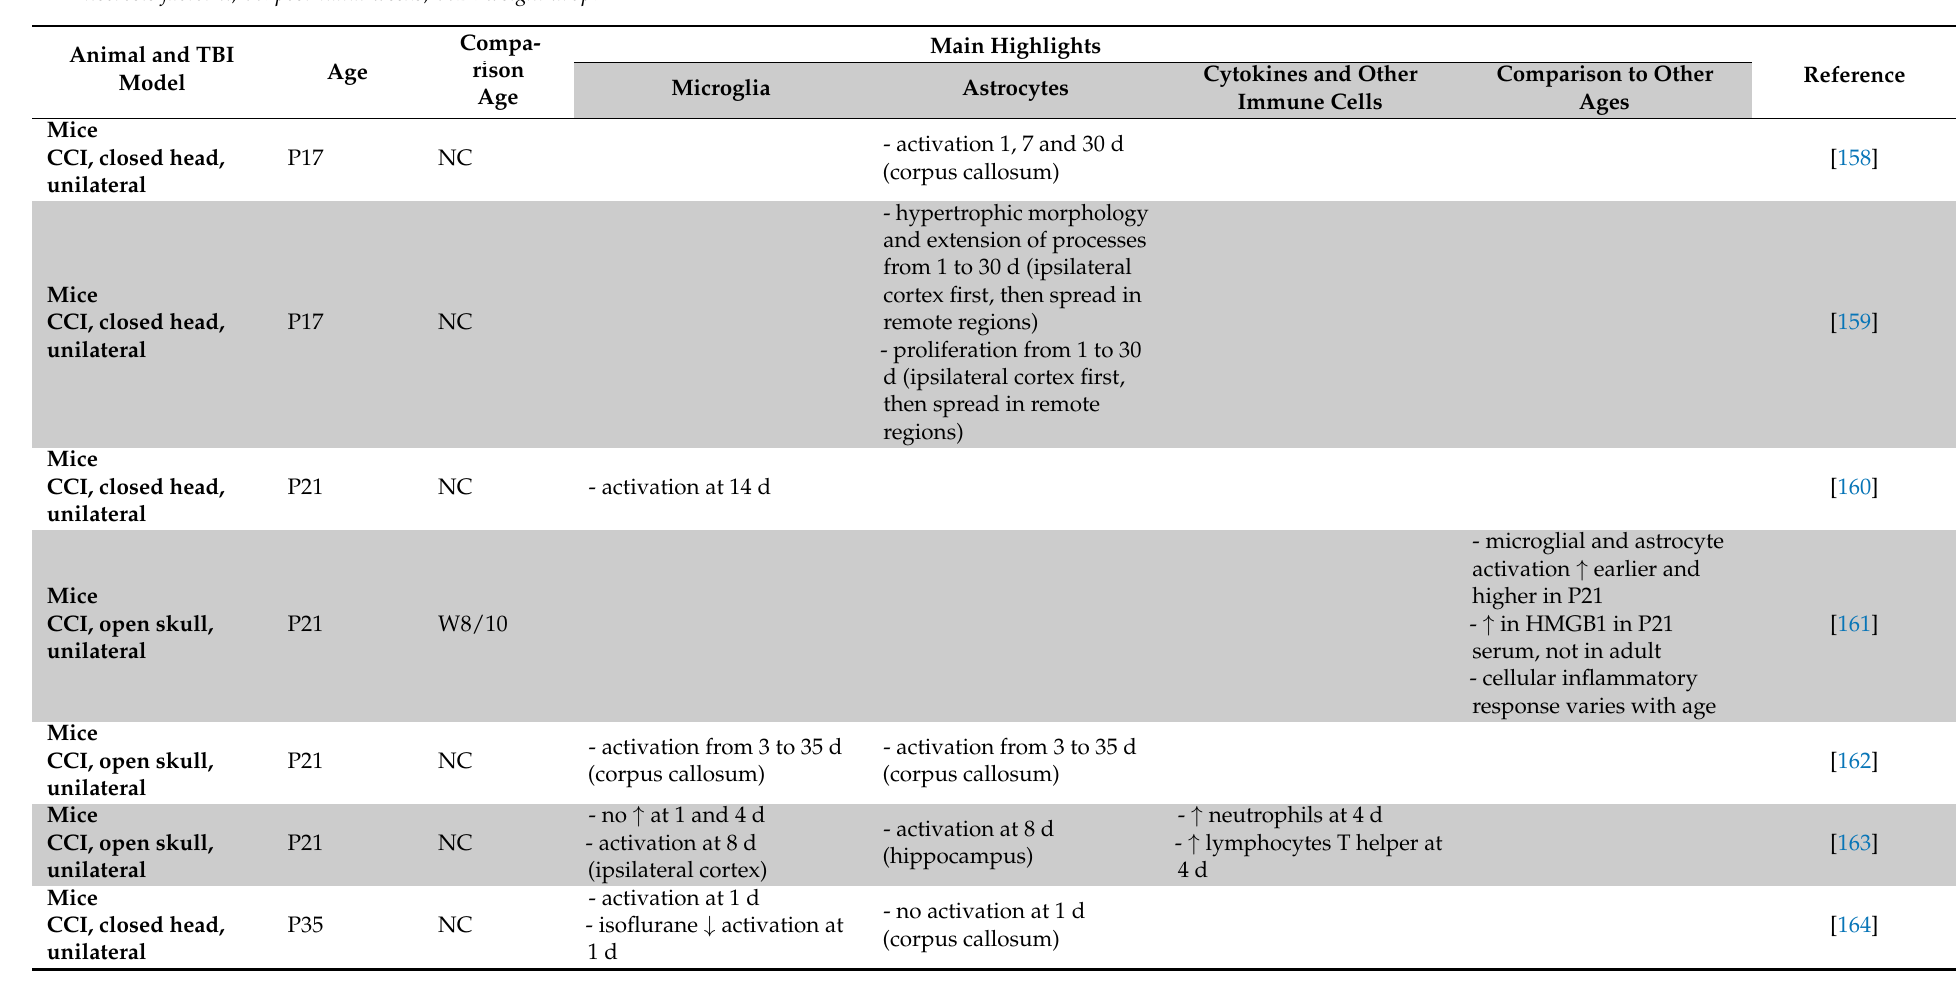
Table 2. Post-traumatic inflammatory consequences on juvenile and adolescent animals. Abbreviations: ↑ : increase; ↓ : decrease; CCI: controlled cortical impact; CCL2: chemokine ligand 2; d: days post-injury; h: hours post-injury; HMGB1: high-mobility group box 1; IL: interleukin; LFP: lateral fluid percussion; NC: not compared; P: post-natal days; TBI: traumatic brain injury; TNF α : tumor necrosis factor α ; W: post-natal weeks; WD: weight drop